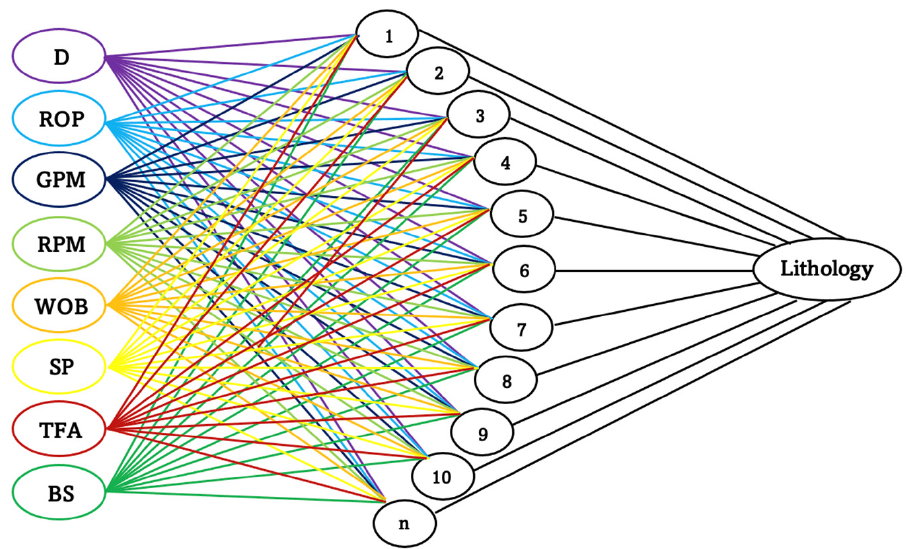
Table 1. The range of data used for the lithology model.